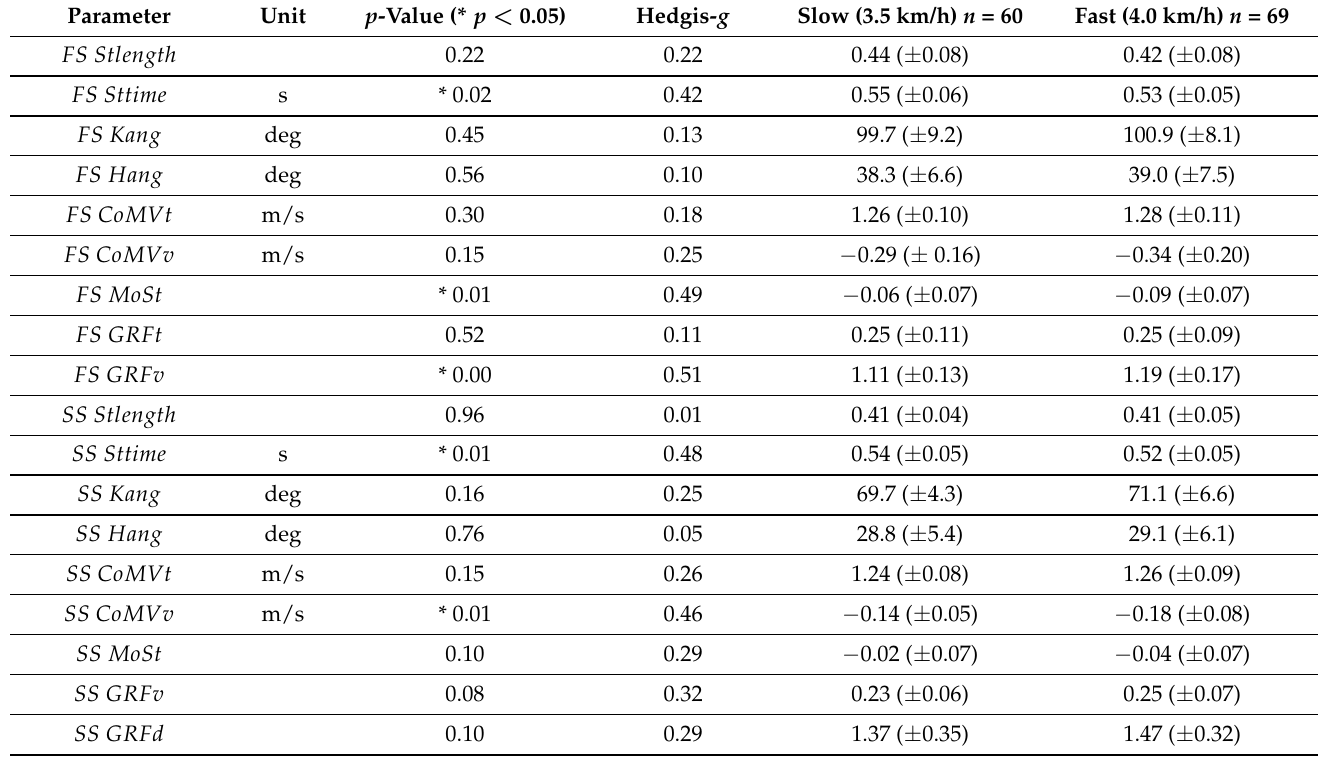
Table 2. Recovery motion parameters between different gait speeds, mean